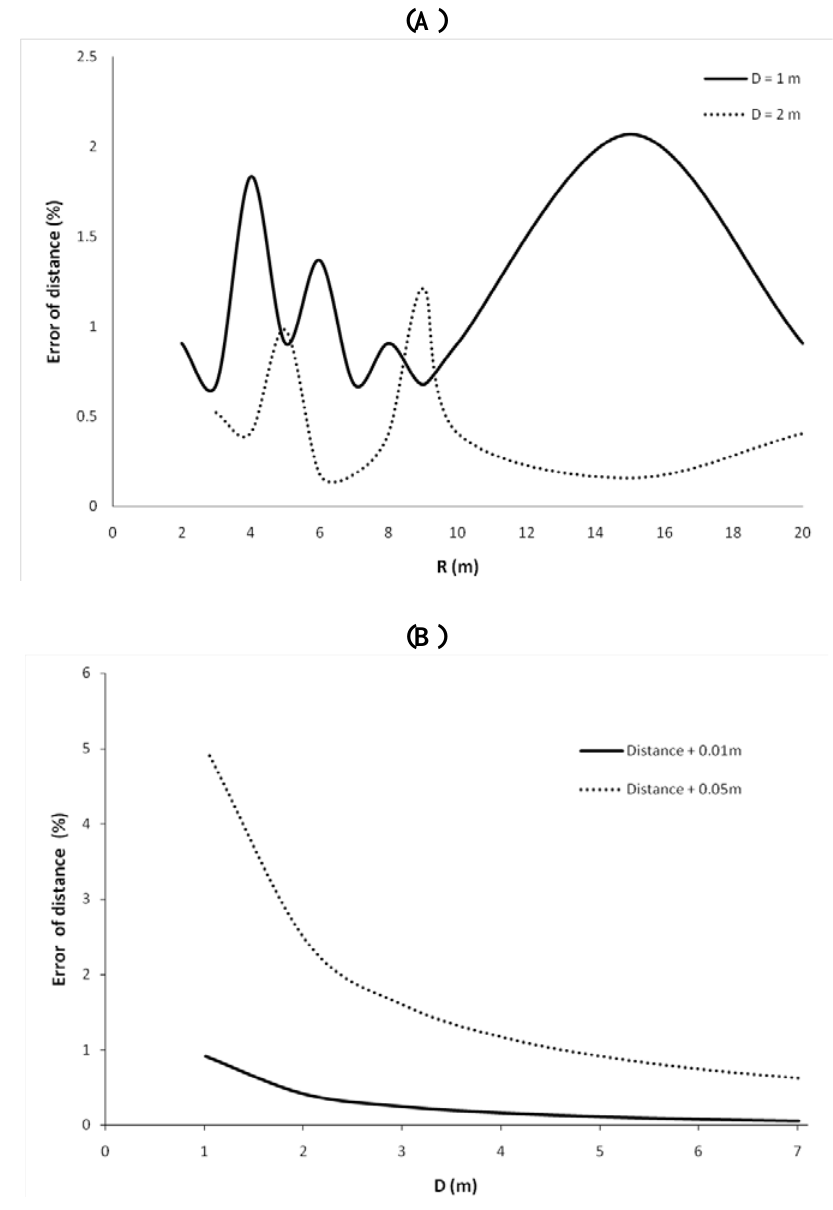
Figure 10. (A) Relationship between the distance and the calculation error on the distance due to a position shift (1 cm) of one camera for baseline length D of 1 and 2 m. (B) Relationship between baseline length D and the calculation error of the distance due to a position shift of 1 and 5 cm of one camera for an object placed on 20 m. (C) Relationship between baseline length D and the calculation error of the distance of the object located on 40 m with a rotation error of 1 and 5 degrees. A linear relation is observed with the inverse distance